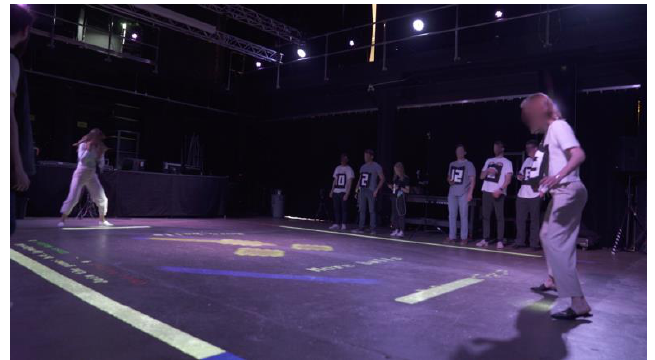
Figure 1. The game GRiD Crowd by Moment Factory (2019) [9].